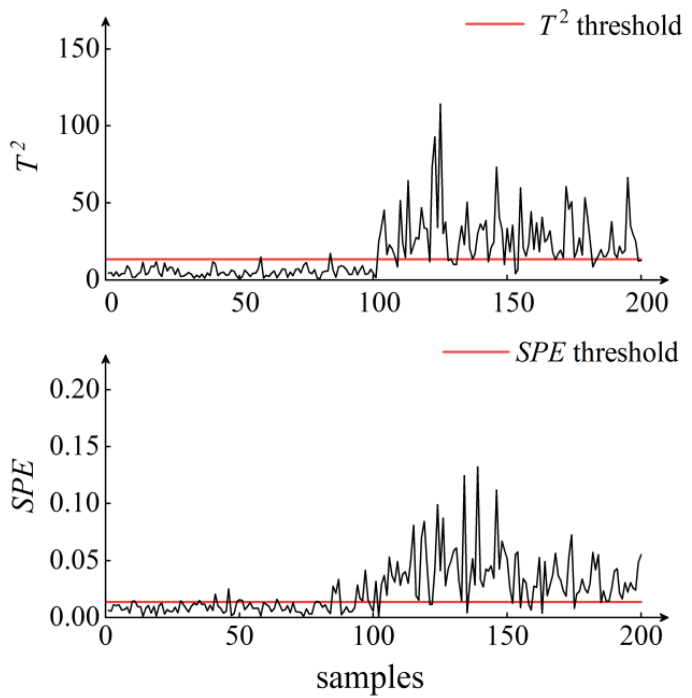
Figure 11. W-KPLS monitoring of sample 1.